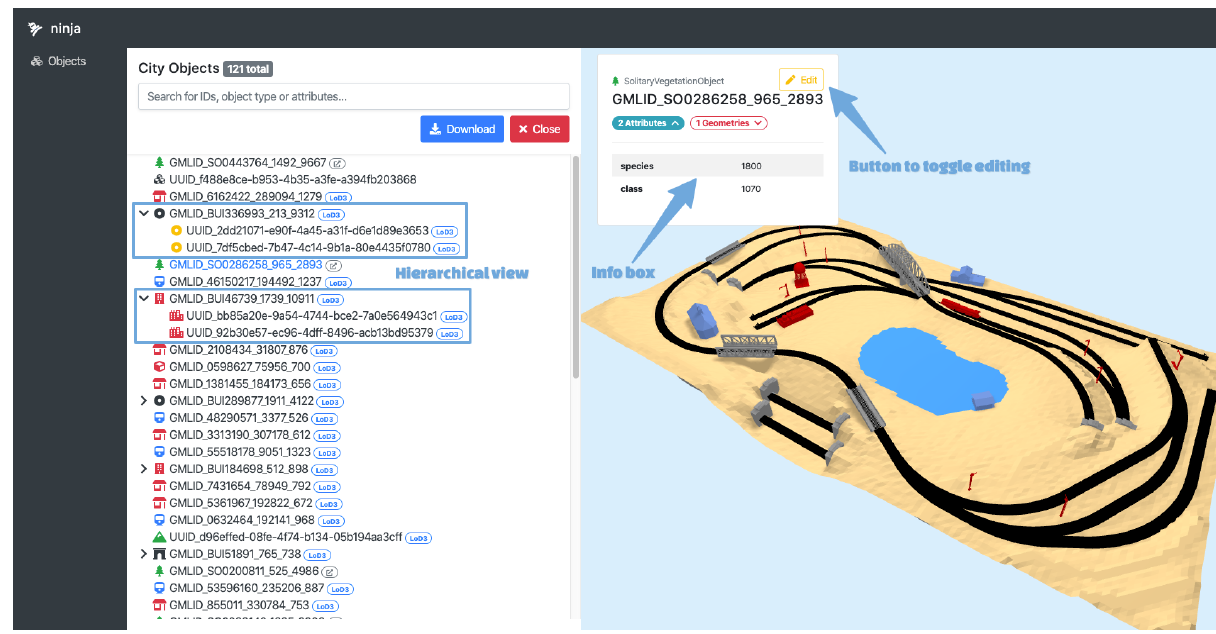
Figure 1. Once a CityJSON file is loaded, the user will see the viewer on the right and the tree-view on the left. version, the main metadata is shown: the author, the time of submission, and the version’s commit message. The list can be used to select or download an individual version. When a ver- sion is selected, the tree-view and 3D view is updated to show only the version-specific